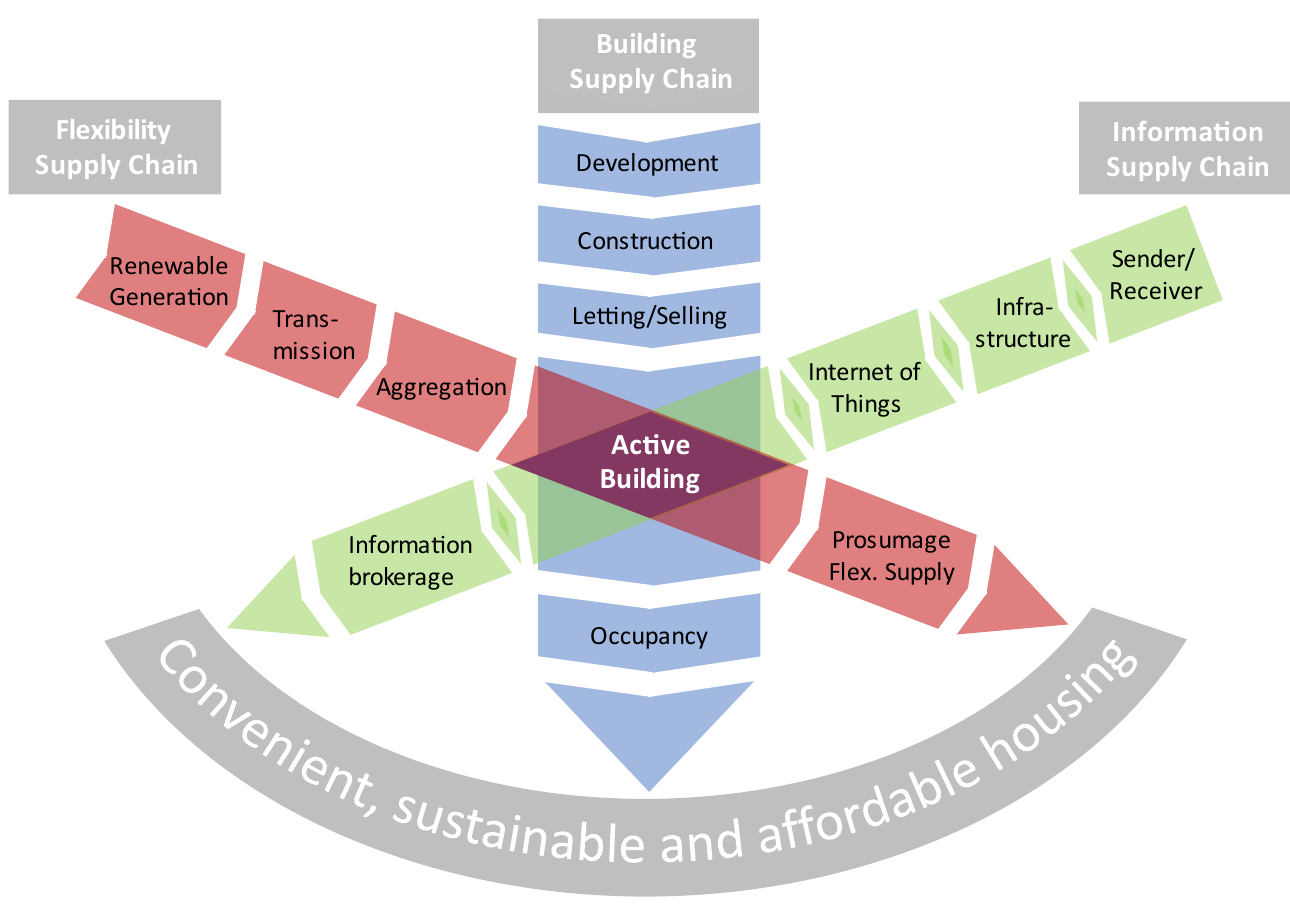
Figure 2. Value chains involving Active Buildings.